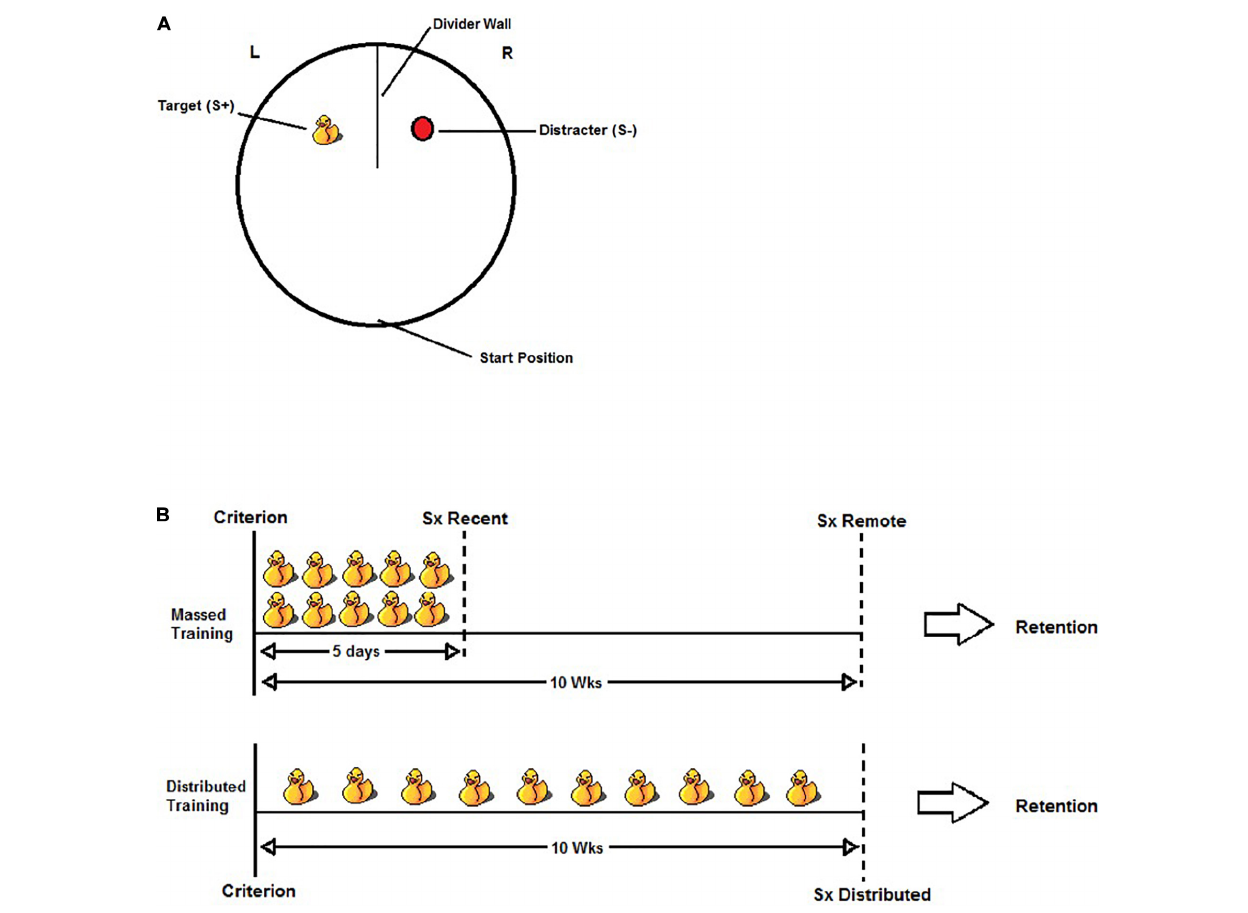
FIGURE 1 | (A) Illustration of the visual discrimination task. Rats were released from the start position and given a maximum of 60 s to swim to the S+ and escape from the water. A trial was considered correct if the rat swam to the S+ and climbed onto the hidden platform without first entering the S– quadrant. A trial was considered incorrect if the rat’s entire body (excluding tail) entered the S– quadrant. The S+ was counterbalanced within groups such that the rubber duck was the S+ for half the rats and the red buoy was the S+ for the other half. The location of S+ was also pseudo-randomly counterbalanced across trials within a swim session so that the rats would learn to swim to the S+ and not a discrete quadrant of the pool. (B) Illustration of the experimental design for the massed training condition (top) and the distributed training condition (bottom). After reaching criterion (defined as > 80% accuracy over two consecutive days), all rats were given an additional 50 discrimination trials (each duck represents five trials). In the Massed Training condition, the rats received 50 additional trials over 5 days (10 trials per day). The Recent group received either sham or HPC surgery (Sx) 5–10 days following the last day of training, whereas the Remote group received sham or HPC surgery 10 weeks following the last day of training. In the Distributed training condition, the rats received the additional 50 training trials distributed over 10 weeks (five trials in one session per week). The distributed training group received sham or HPC surgery 5–10 days following their last day of training (approximately 10–11 weeks after reaching criterion). In all cases, the rats were given a minimum of 10 days recovery before testing for